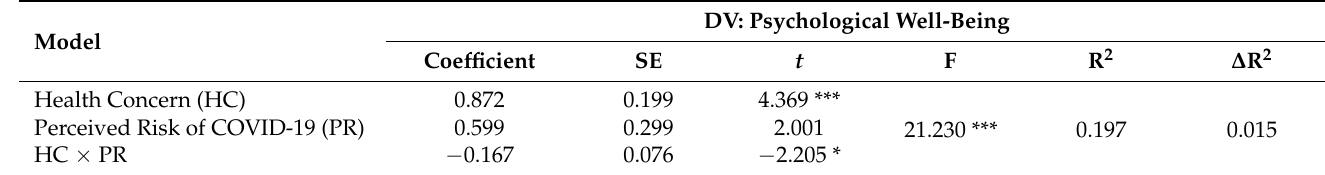
Table 6. Moderating effect of perceived risk of COVID-19.